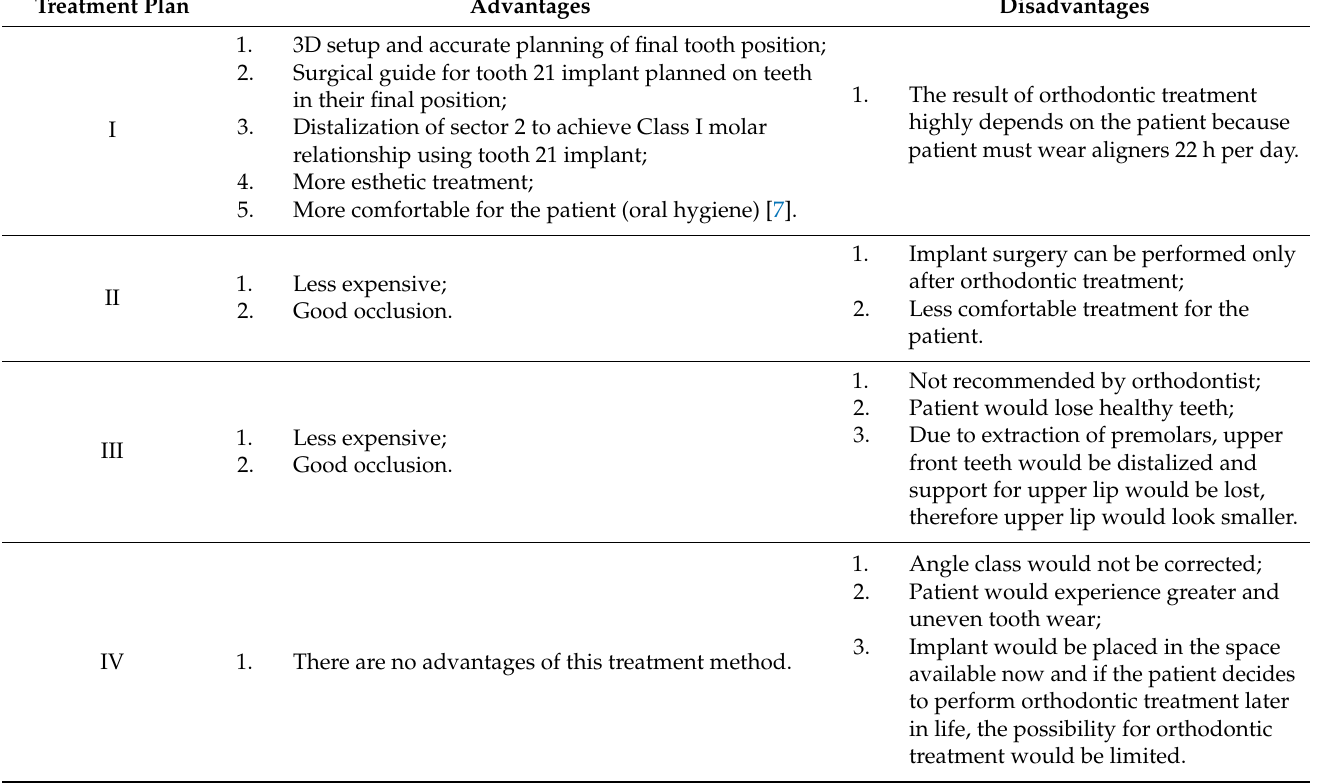
Table 1. Advantages and disadvantages of the suggested treatment plans.